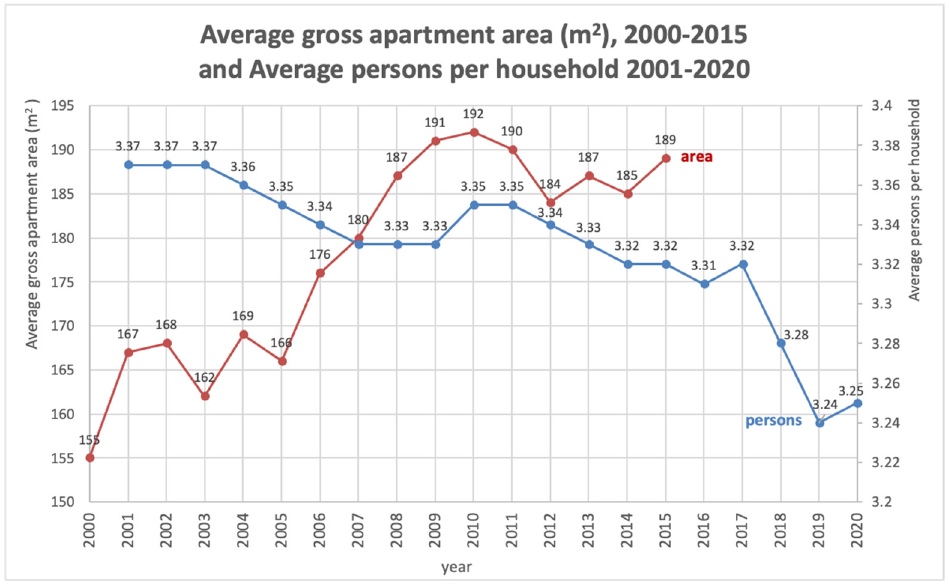
Figure 2. The evolution of average gross apartment area (2000–2015) and average persons per household (2001–2020). Data source: Israel Central Bureau of Statistics.